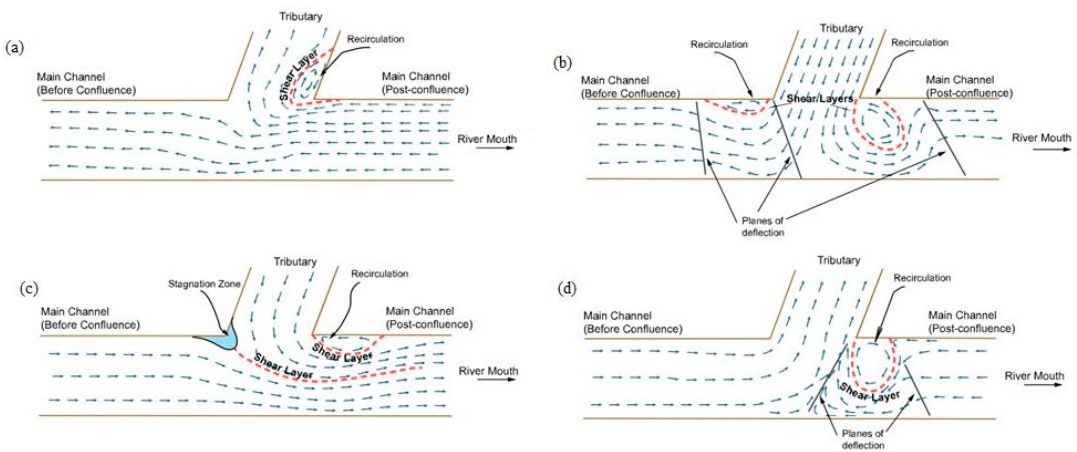
Figure 6. Schematic of flow scenarios used for studying the hydrodynamics of tidal confluences.